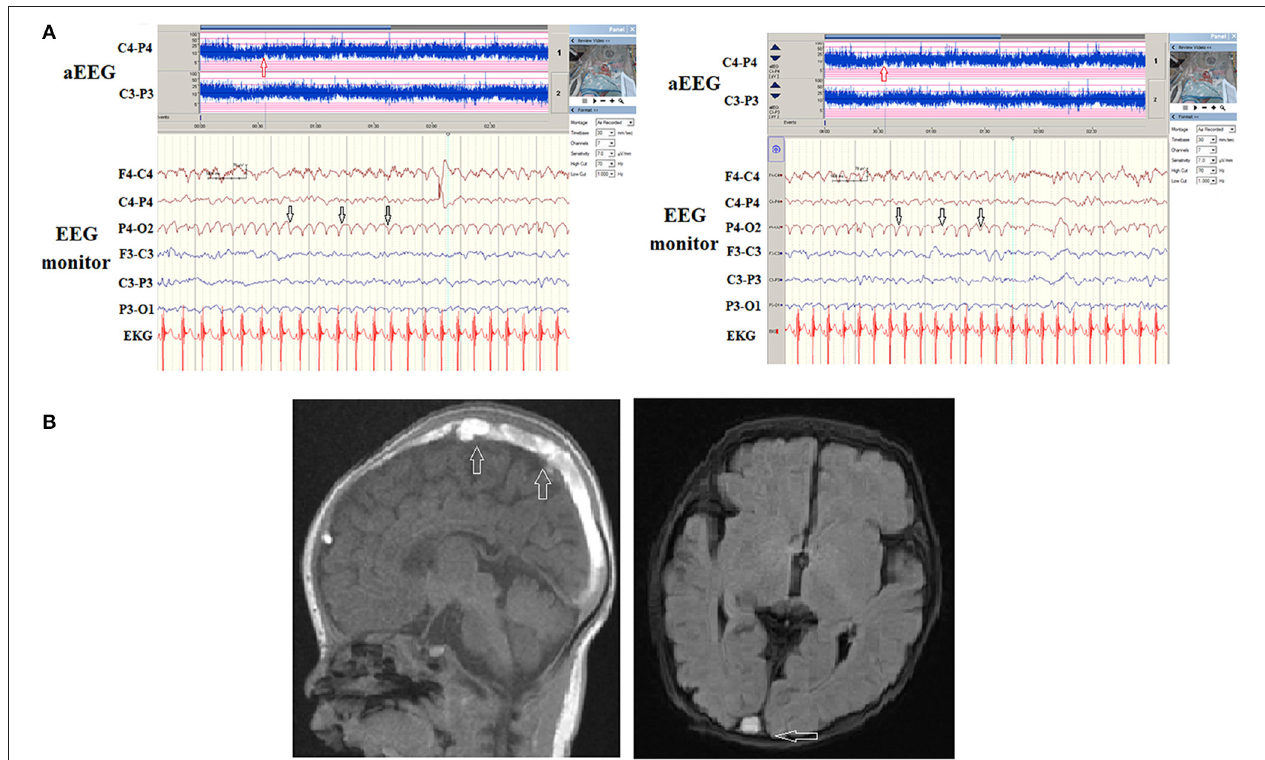
FIGURE 1 | (A) A patient with stage I hypoxic - ischemic encephalopathy (HIE). However, during the automated electroencephalography (aEEG) and electroencephalography (EEG) monitor, recurrent paroxysmal focal delta waves were noticed right posterior regions (white arrows) on EEG monitor and a notch on aEEG (red arrows). (B) The magnetic resonance imaging (MRI) and magnetic resonance venography ( MRV) exhibited diffuse thrombosis (arrows) of superficial great vein with small hemorrhage of right occipital